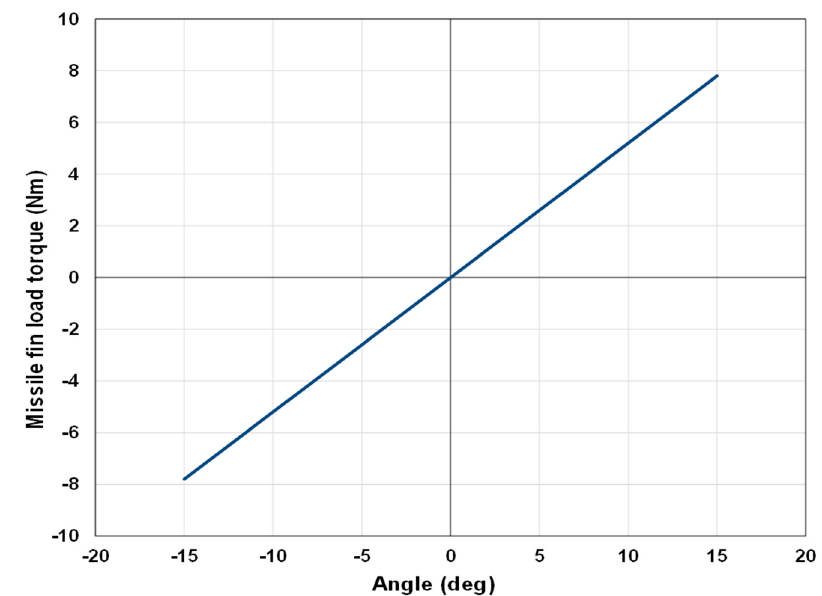
Figure 4. System A architecture.